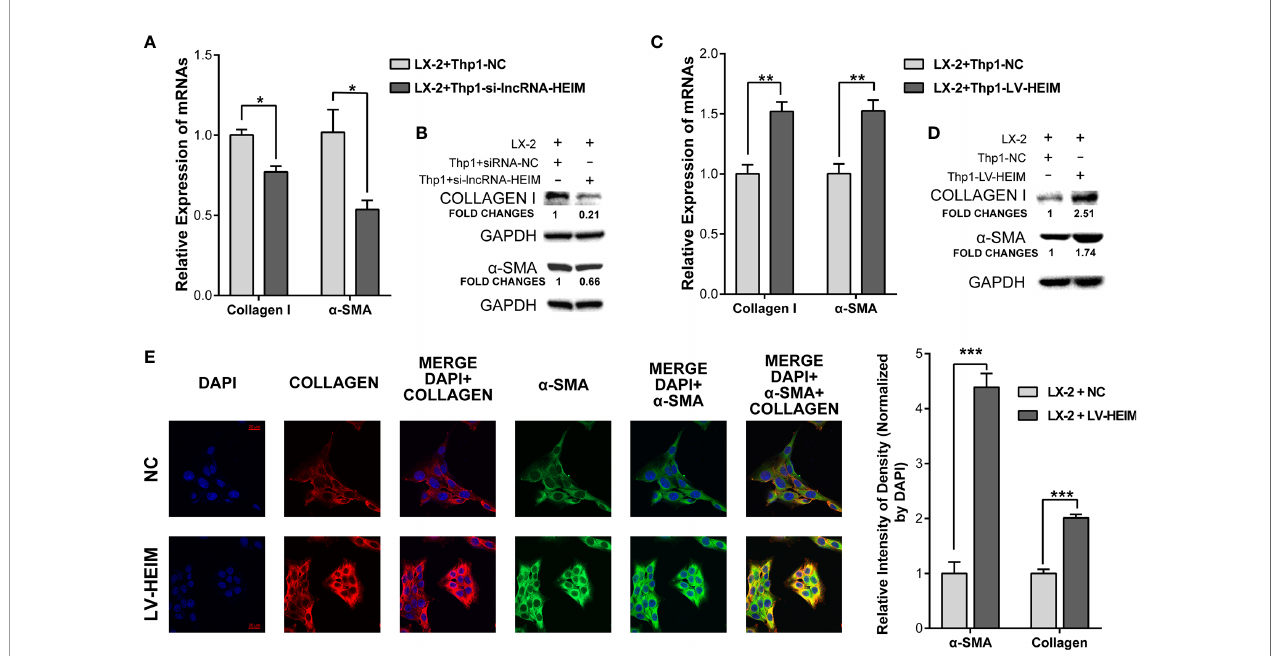
FIGURE 5 | lncRNA-HEIM dramatically facilitated the fi brosis of hepatic stellate cells. (A, B) Relative mRNA expression and western blotting assays of collagen I and a -smooth muscle actin ( a -SMA) in hepatic stellate cells (HSCs) co-cultured with monocytes transfected with siRNAs for lncRNA-HEIM or NC. Chemiluminescent densities in (B) were normalized with GAPDH, and fold changes were calculated based on NC. ∗ p < 0.05. (C, D) Relative mRNA expression and western blotting assays of collagen I and a -smooth muscle actin ( a -SMA) in HSCs co-cultured with LV-HEIM stable monocytes or NC. Fold changes in (D) , same as above. ∗∗ p < 0.01. (E) Confocal imaging of collagen-I (red), a -SMA (green), and DAPI (blue) in HSCs co-cultured with LV-HEIM stable monocytes or NC. Scale bar: 20 m m. Relative intensity of density normalized by DAPI was depicted on the right. ∗∗∗ p <